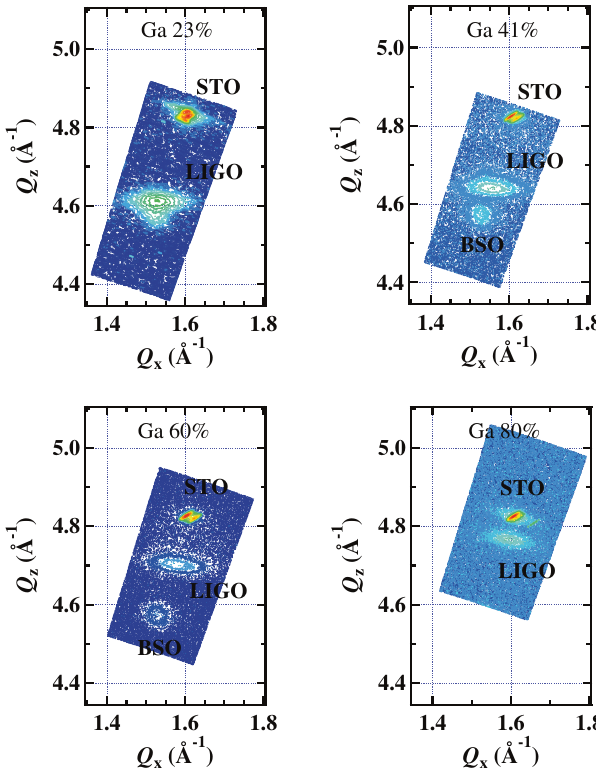
Fig. 4 Reciprocal space maps in various Ga alloying ratios. Maps are of